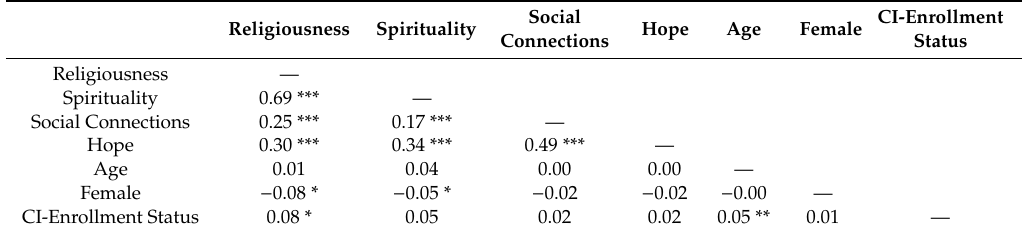
Table 2. Correlations among the latent factors.